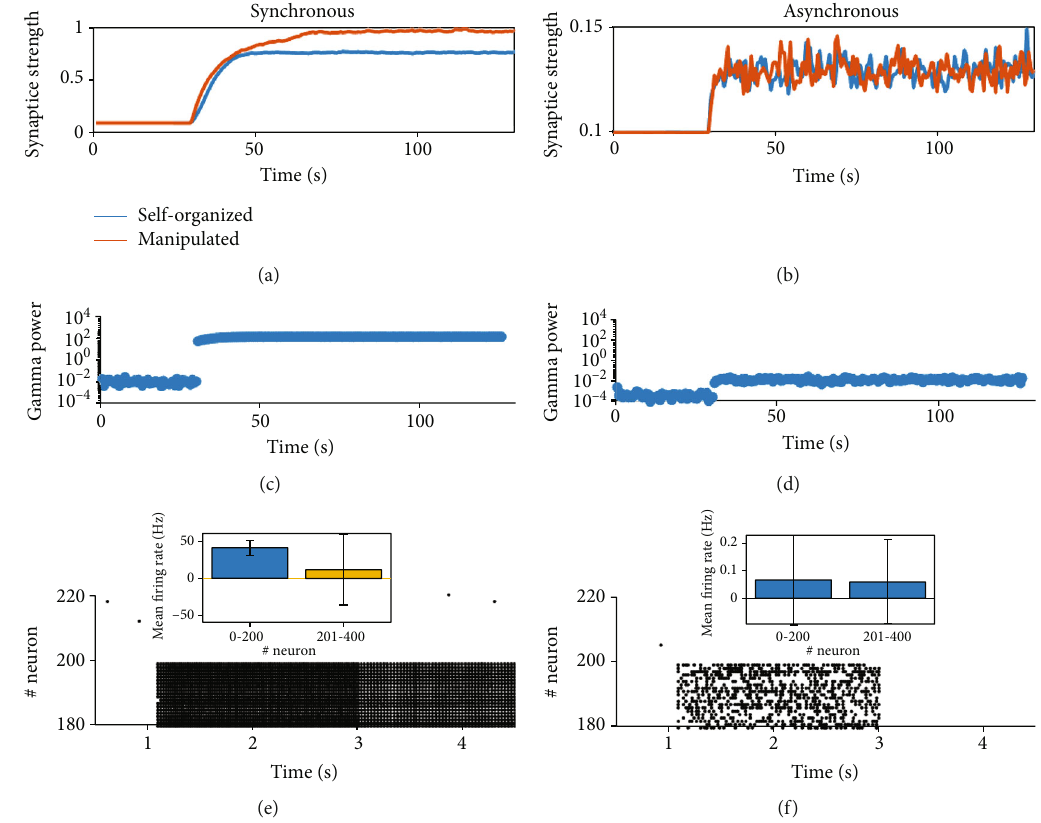
Figure 4: Properties of circuits with plasticity. (a, b) Synaptic weight evolution. Blue curves are results from networks with plasticity, whereas orange curves are from virtual networks in Figure 3. (c, d) The evolution of gamma oscillation and synaptic weight in di ff erent dynamical state. (e, f) The ability of working memory maintenance after recalling in the network after learning. Extra stimuli ( As = 5 ) are applied to the neuron group with memory encoded for 2 s (from 1s to 3 s). The persistent fi ring ability of the group after extra stimuli removal is checked. The insets compare the fi ring rate of the memory-coding group and the fi ring rate of other neurons during the persistent period. (a, c, e) Synchronous state. τ E = 6ms : (b, d, f) Asynchronous state. τ E = 90ms . The other parameters are set as τ I = 8ms, As = 3 : 5 d d d